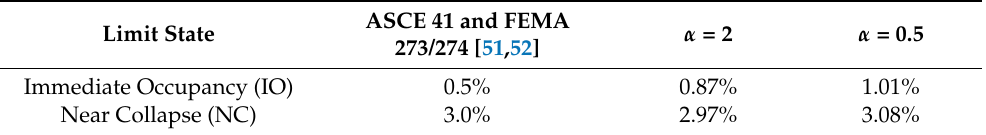
Table 7. Average inter-story drift values for the code-defined limit states with respect to the triggered global failure